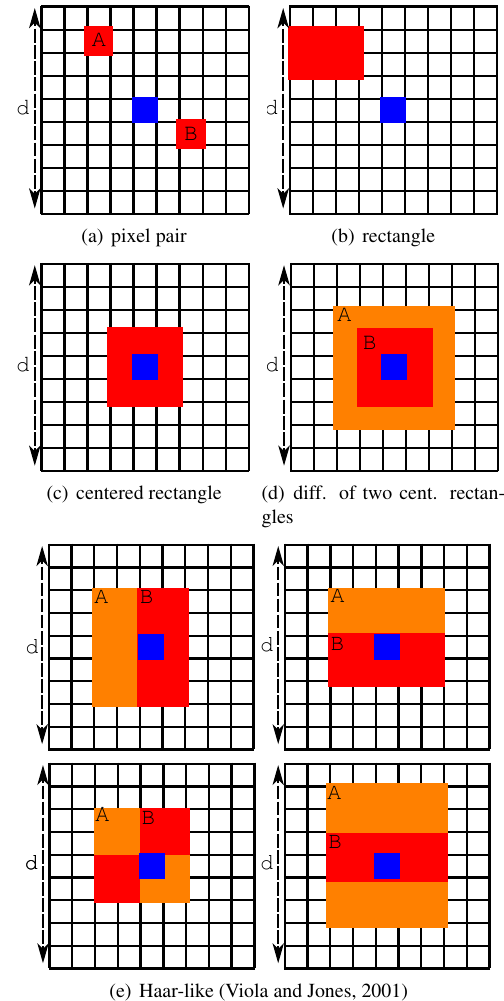
Figure 3: Feature extraction methods from (Fr¨ohlich et al., 2012). The blue pixel denotes the current pixel position and the grid a window around it. The red and orange pixels are used as fea- tures. They can be used as simple feature (c and d) or they can be combined, e.g., by A + B , A − B or | A − B | (a,b and e). in the height. Adding the NDVI helps to reduce the confusion between the classes grassland and bare soil (Figure 6(c)). This is also what we expected, due to the fact that grassland has a much brighter appearance in the NDVI image than bare soil . But there are still some confusions between bare soil and grassland . On